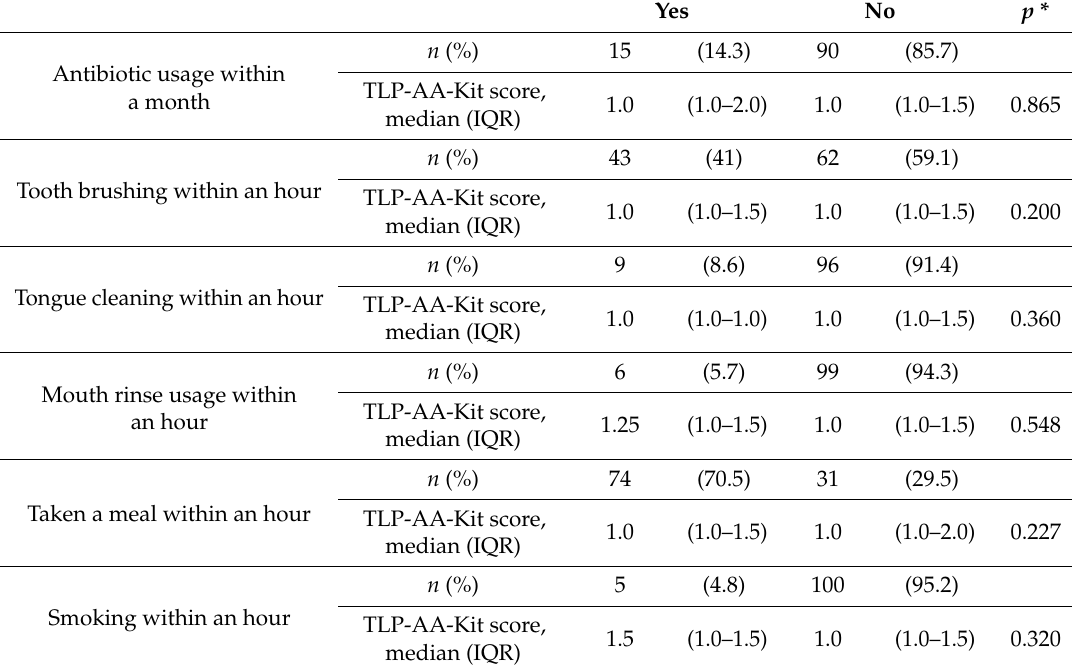
Table 2. TLP-AA-Kit scores according to the selected behavior prior to examination.